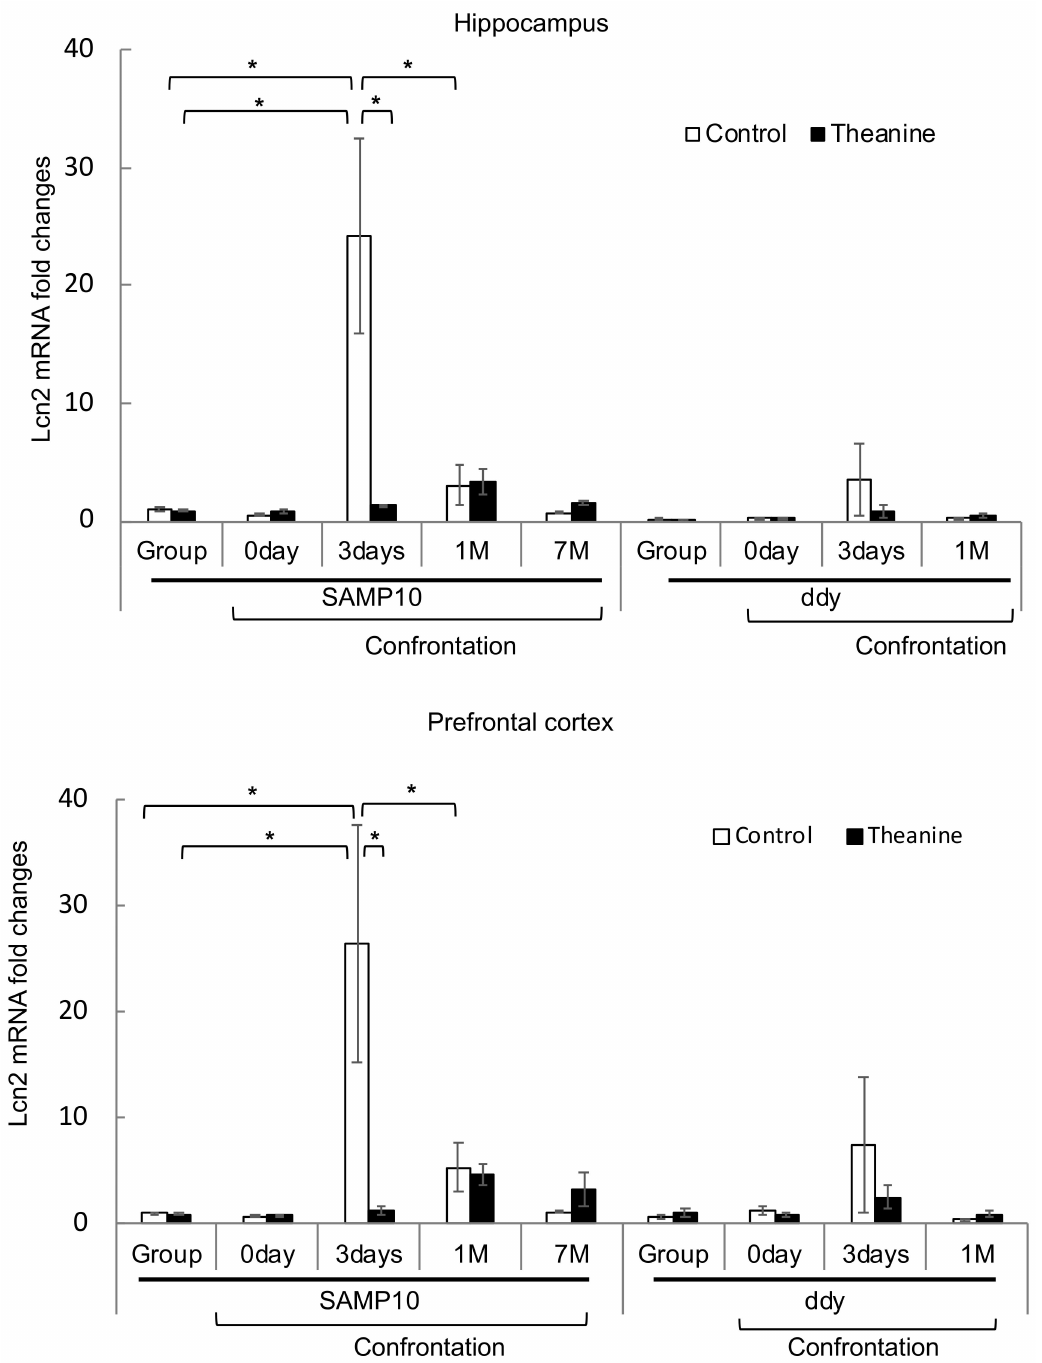
Figure 7. Expression levels of Lcn2 mRNA in the hippocampus and prefrontal cortex of SAMP10 and ddY mice. Mice consumed theanine (20 µ g / mL water, closed bar) or normal tap water (control, open bar) ad libitum. After single housing for one month, hippocampal and prefrontal cortex samples were obtained from mice housed confrontationally for 0 days, 3 days, 1 month, and 7 months. Group-housed mice were kept in a cage for two months. Values are expressed as means ± SEM ( n = 3–6, * p <